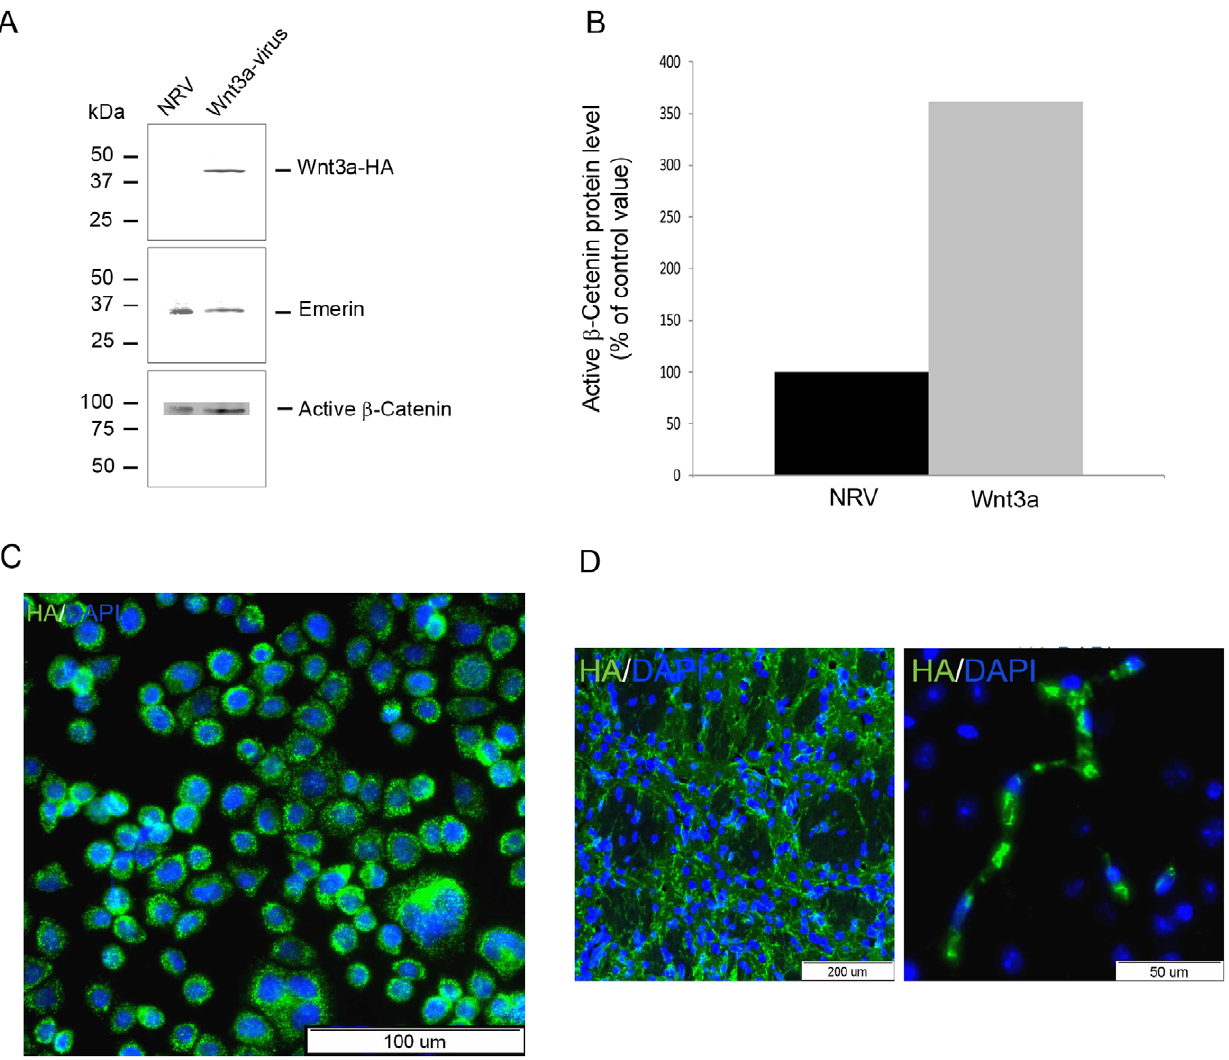
Figure 2. In vitro and in vivo validation of LV-Wnt3a-HA over-expression. A–C. HeLa cells were infected with LV-Wnt3a-HA and confirmation of over-expression was performed using Western blot analysis (A) and immunocytochemistry (C). The ability of Wnt3a-HA to functionally activate Wnt signaling was confirmed by assessing active b -catenin (A) followed by densitometry measurements (B). Cells infected with non-related virus (NRV) were used as control. D. In vivo expression of exogenous Wnt3a-HA was detected one month after injection in the